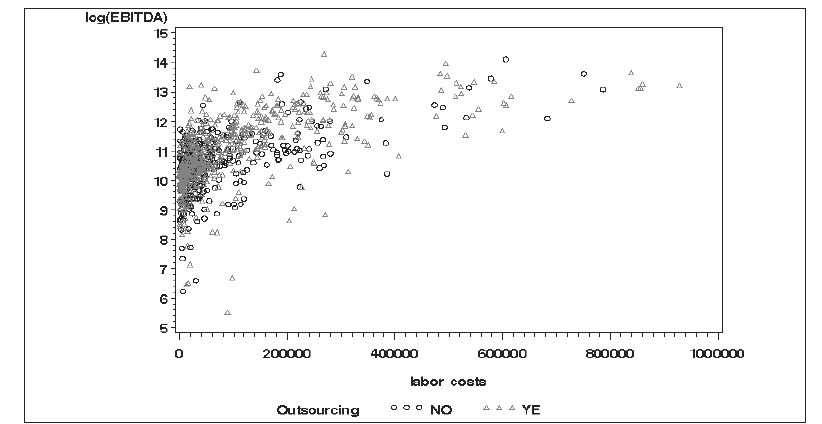
Figure 1a – Firms with employees by log(EBITDA) and labour costs (grey triangle outsourcing firms; black circle non-outsourcing firms.)